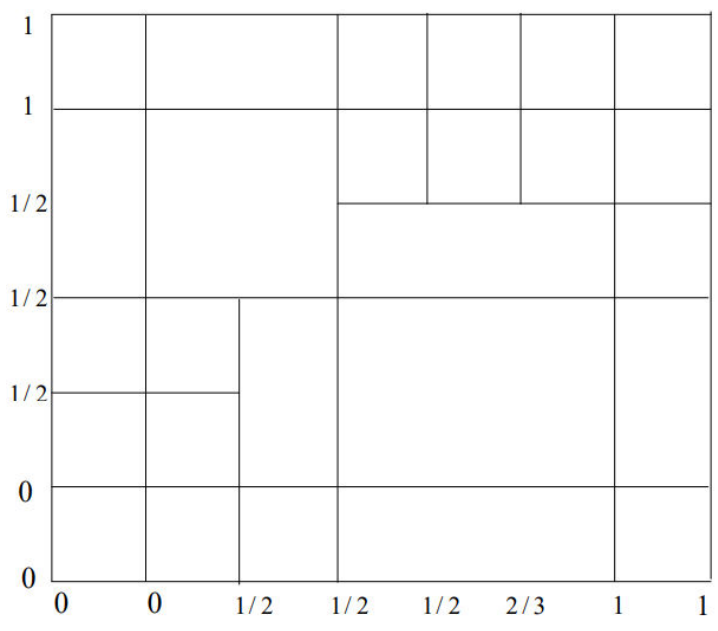
Figure 9. A linearly dependent T-spline of degree three